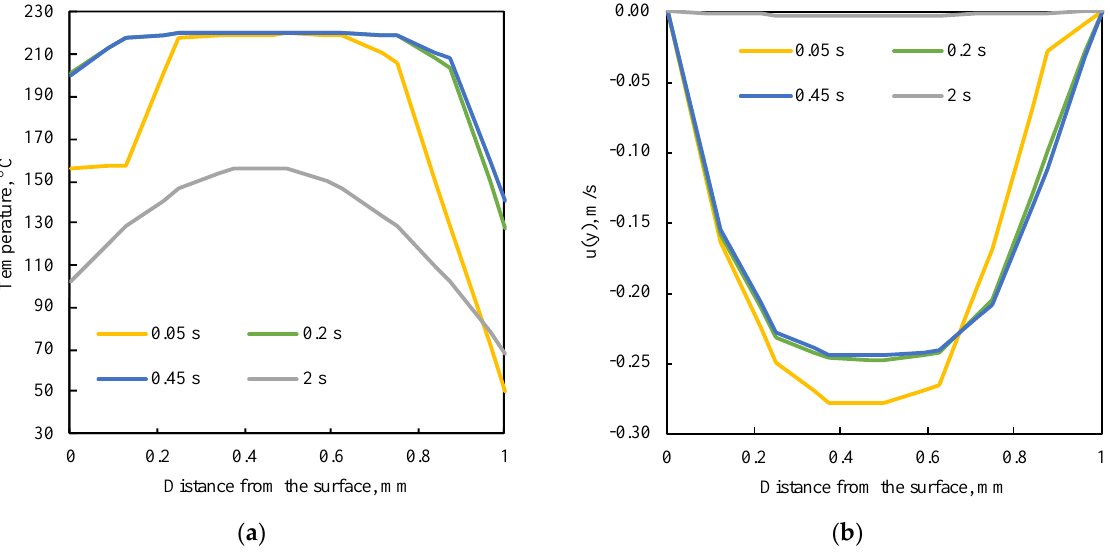
Figure 7. ( a ) Temperature distribution along the cavity thickness for the case with a 68 W heating power. ( b ) Velocity distribution, y-component, along the cavity thickness at several times during the process.